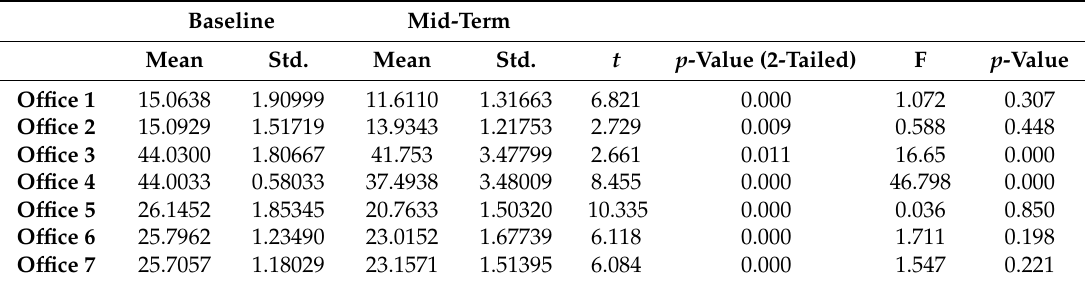
Table 5. Result of the Student’s t -test and Levene’s test performed to assess the difference of means and variances between the baseline data and the mid-term period (Intervention period). All the offices present a lower percentage of energy usage after the experimentation.